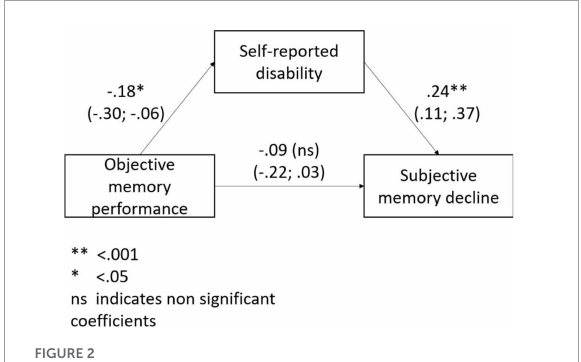
FIGURE2 The mediating role of disability in the association between objective memory performance and subjective memory